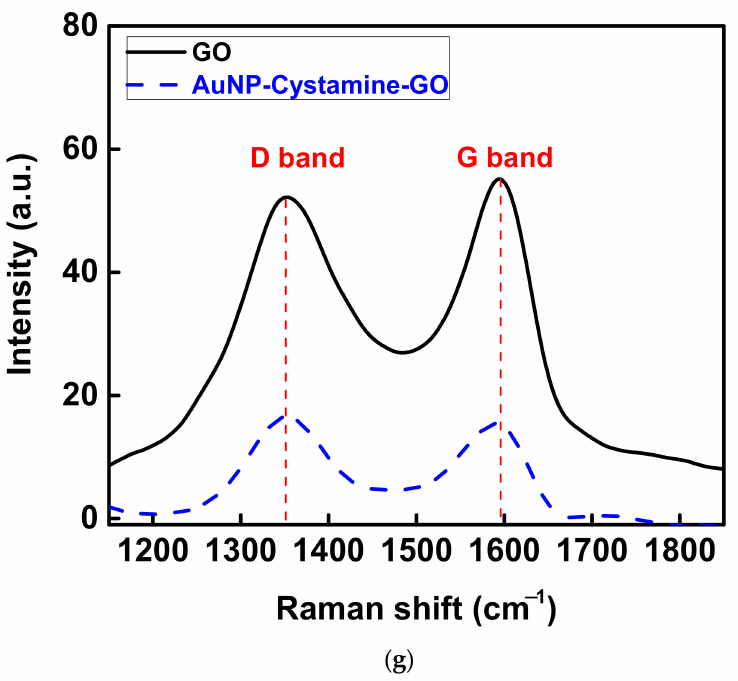
Figure 3. Structural characterizations of materials. ( a ) Absorption spectra of Au nanoparticles (AuNPs) in aqueous medium and the AuNP modified to the slide glass surface measured by UV-Vis spectrum in the visible region; ( b ) SEM image of AuNPs on the sensing chip surface; ( c ) SEM image of graphene oxide (GO); ( d ) SEM image of AuNPs/GO on the sensing chip surface; ( e ) AFM image of AuNPs surface roughness; ( f ) AFM image of AuNP/GO surface roughness; ( g ) Raman spectra of GO and